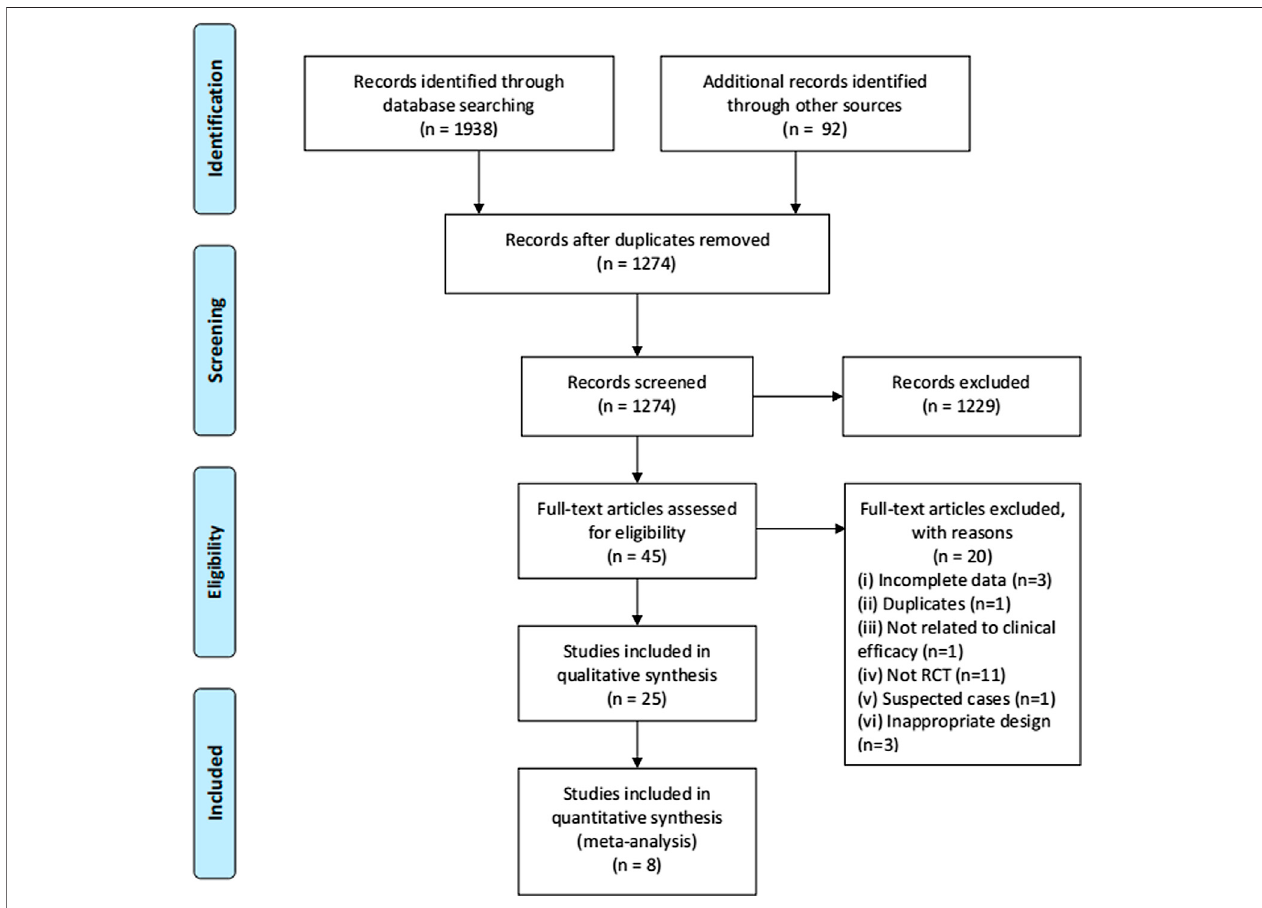
FIGURE 1 | Flowchart of study